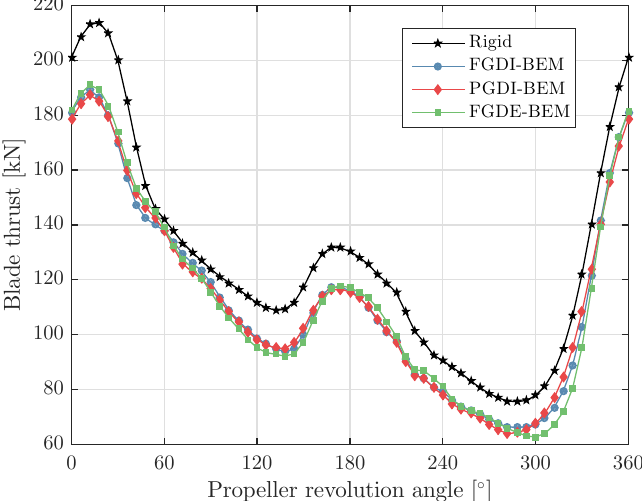
Figure 12. Blade thrust computed with different BEM-FEM couplings for the glass–epoxy Seiun– Maru propeller.